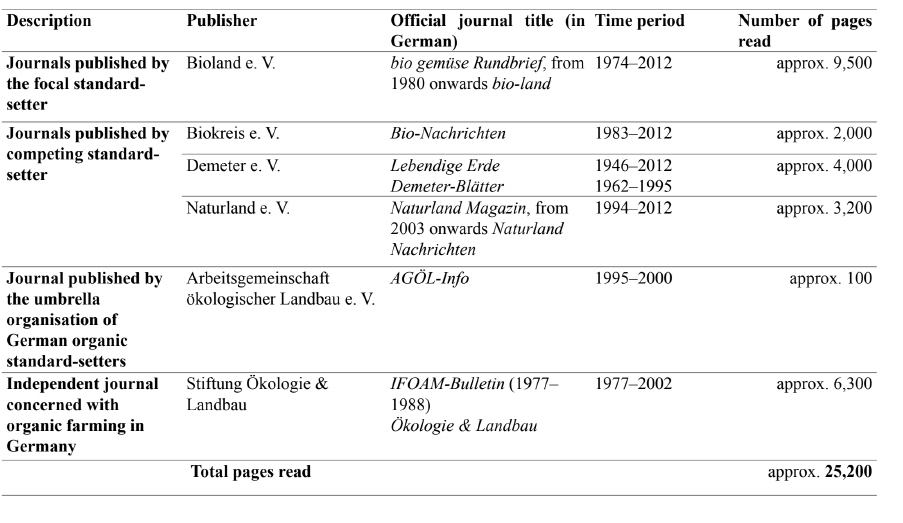
Table 1. Overview of Data